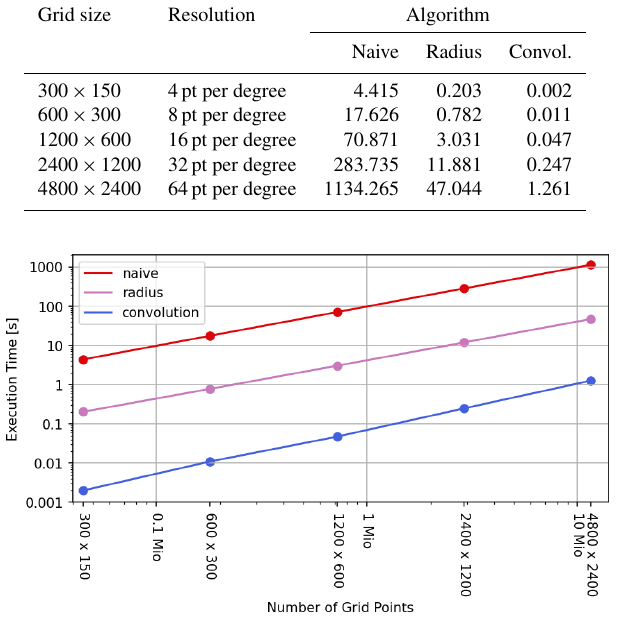
Figure 4. Plot of execution times from Table 1 against number of sample points. Both axes use a logarithmic scale.